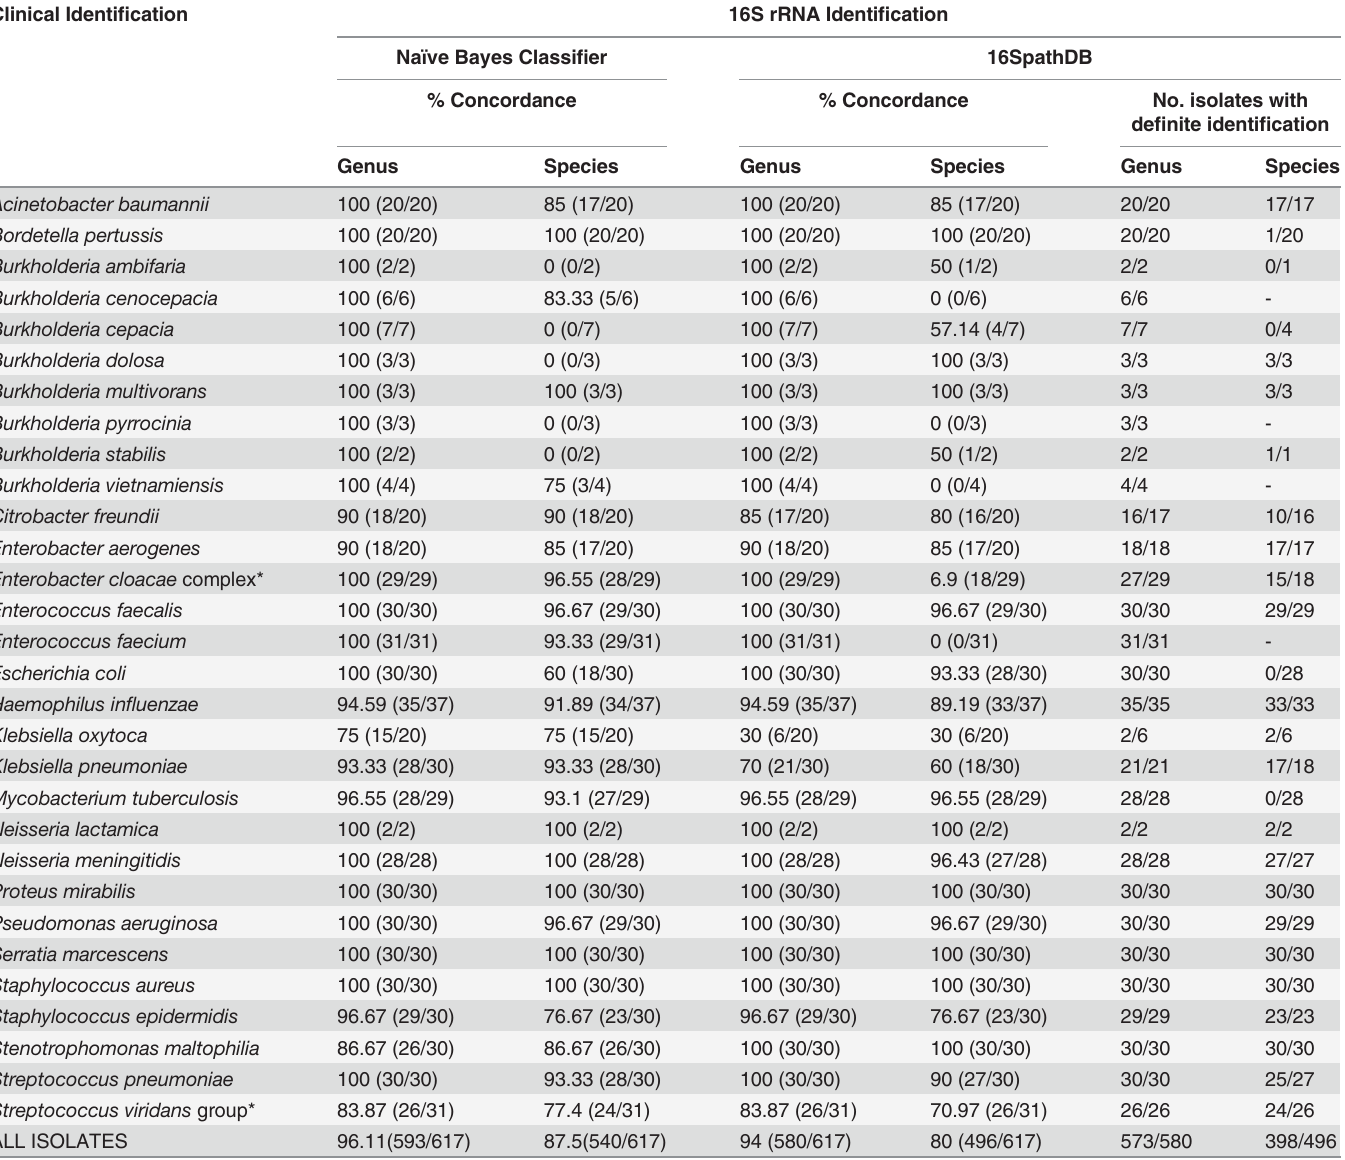
Table 2. Concordance rates between clinical and 16S rRNA based identi fi